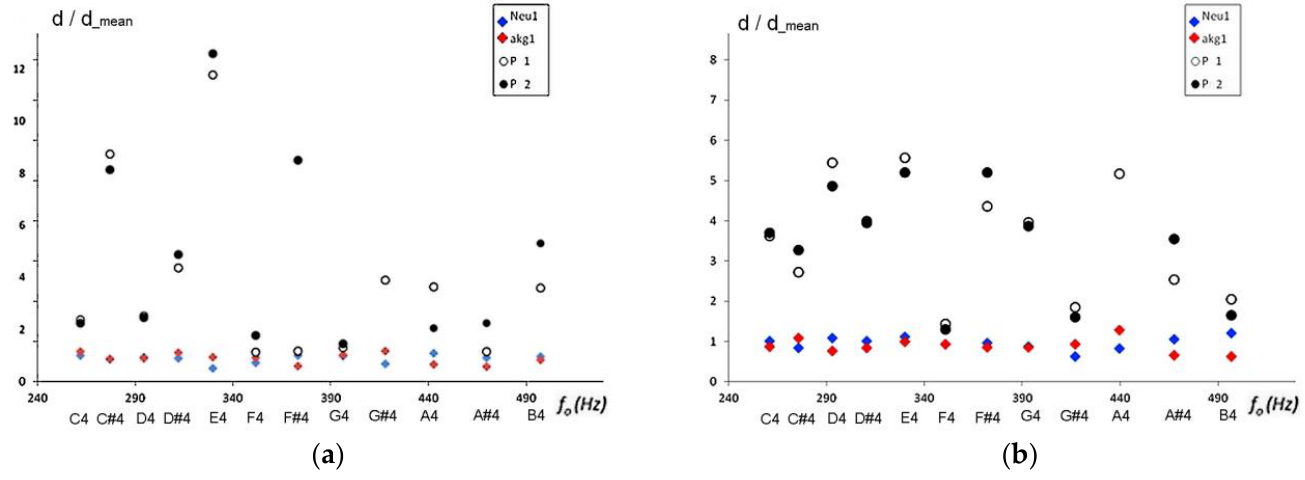
Figure 3. Patterned distance between musical sounds in mezzo — forte for the 4 ta octave, reference sounds in the dataset: ( a ) Clarinet ( b ) Flute.